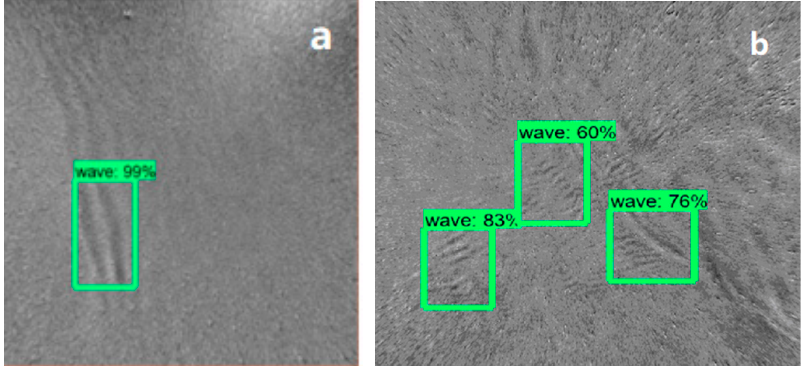
Figure 8. Extraction of unwarped airglow images: ( a ) plane wave, ( b ) multiple ripples. The multiple wave structures are detected in the images and their local regions are marked with green rectangles for extraction. The percentages indicate the confidence values.